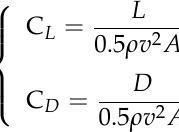
Table 2. Required training data for ANN modeling. Category